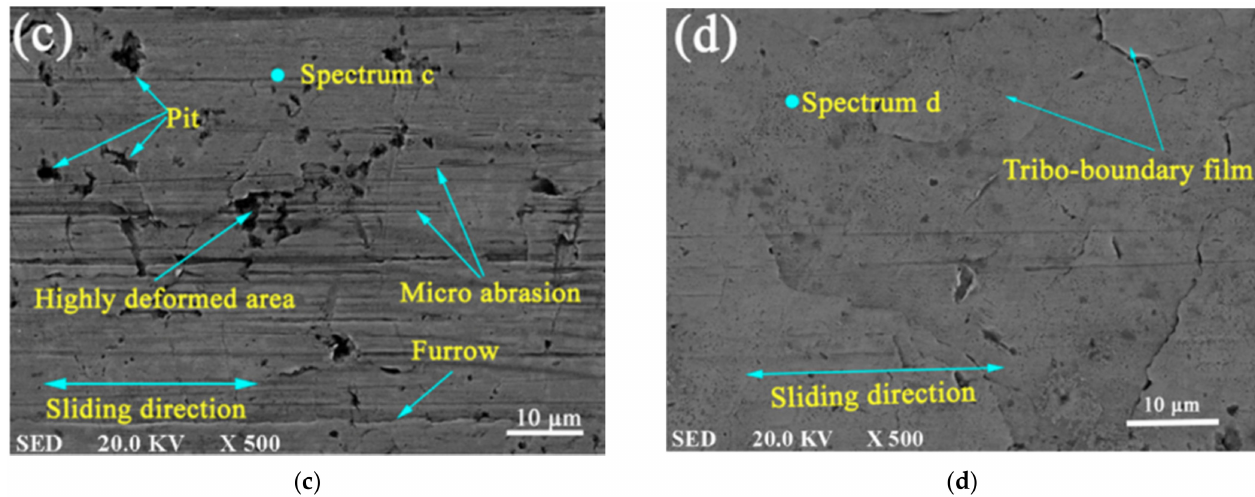
Figure 9. Morphology of the worn surfaces compared with commercial lubricant and hybrid nano-lubricants [56]. ( c ) Cylinder liner with commercial lubricant, ( d ) Cylinder liner with Al2O3/TiO2 hybrid